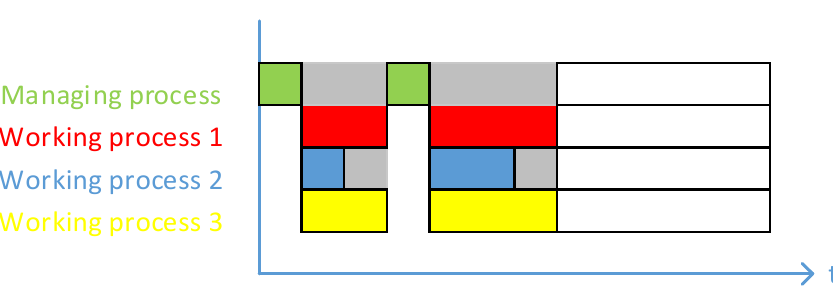
Figure 14. Parallel propulsion for MPPWPA.